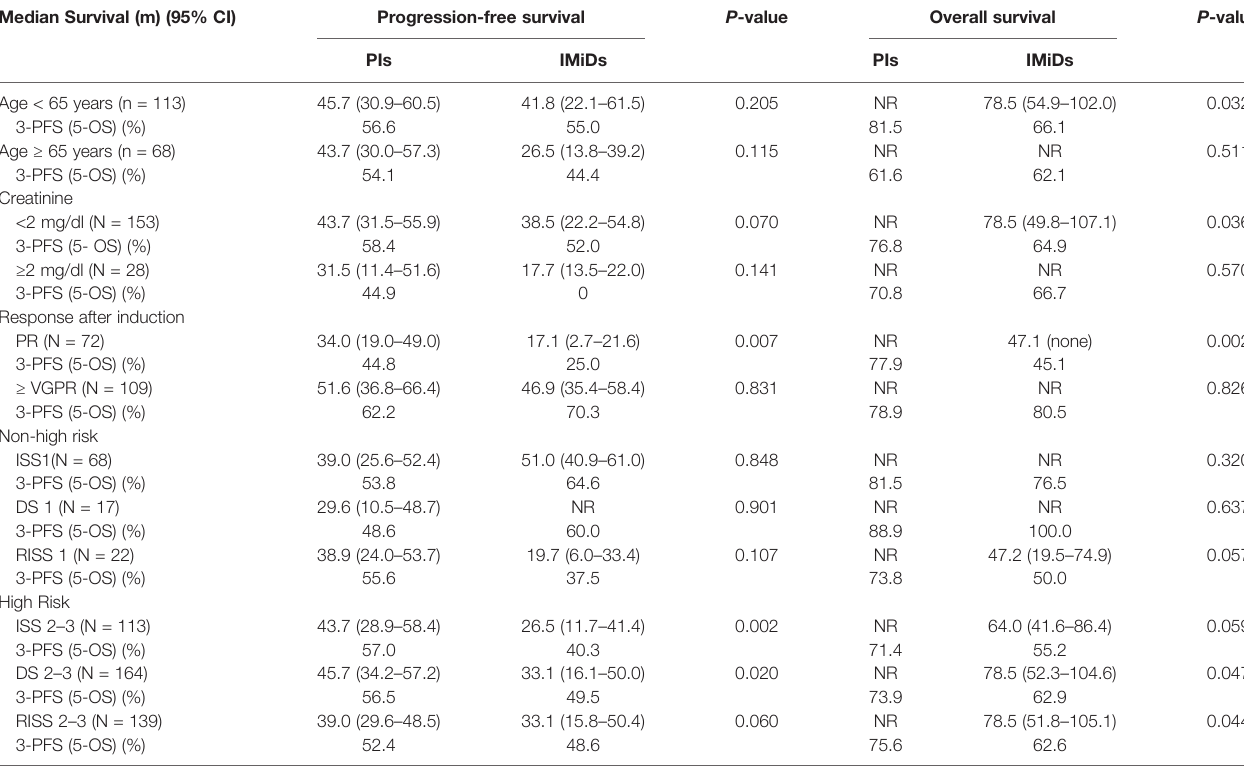
TABLE 3 | Subgroup analysis of NDMM patients who received maintenance therapy of PIs or IMiDs. Median Survival (m) (95% CI)